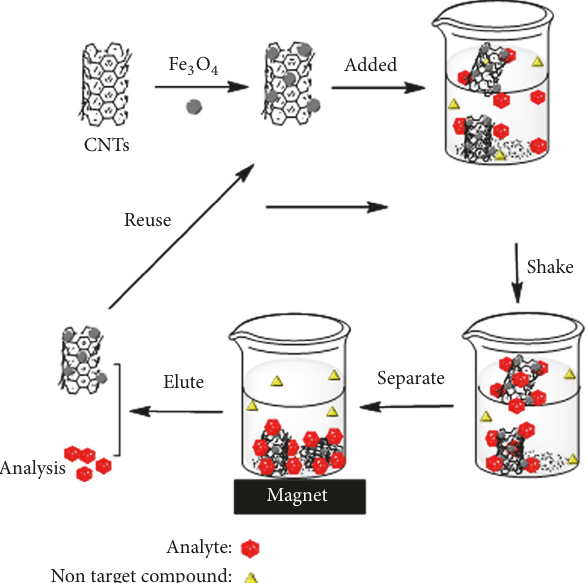
Figure 1: Schematic illustration of extraction procedure.